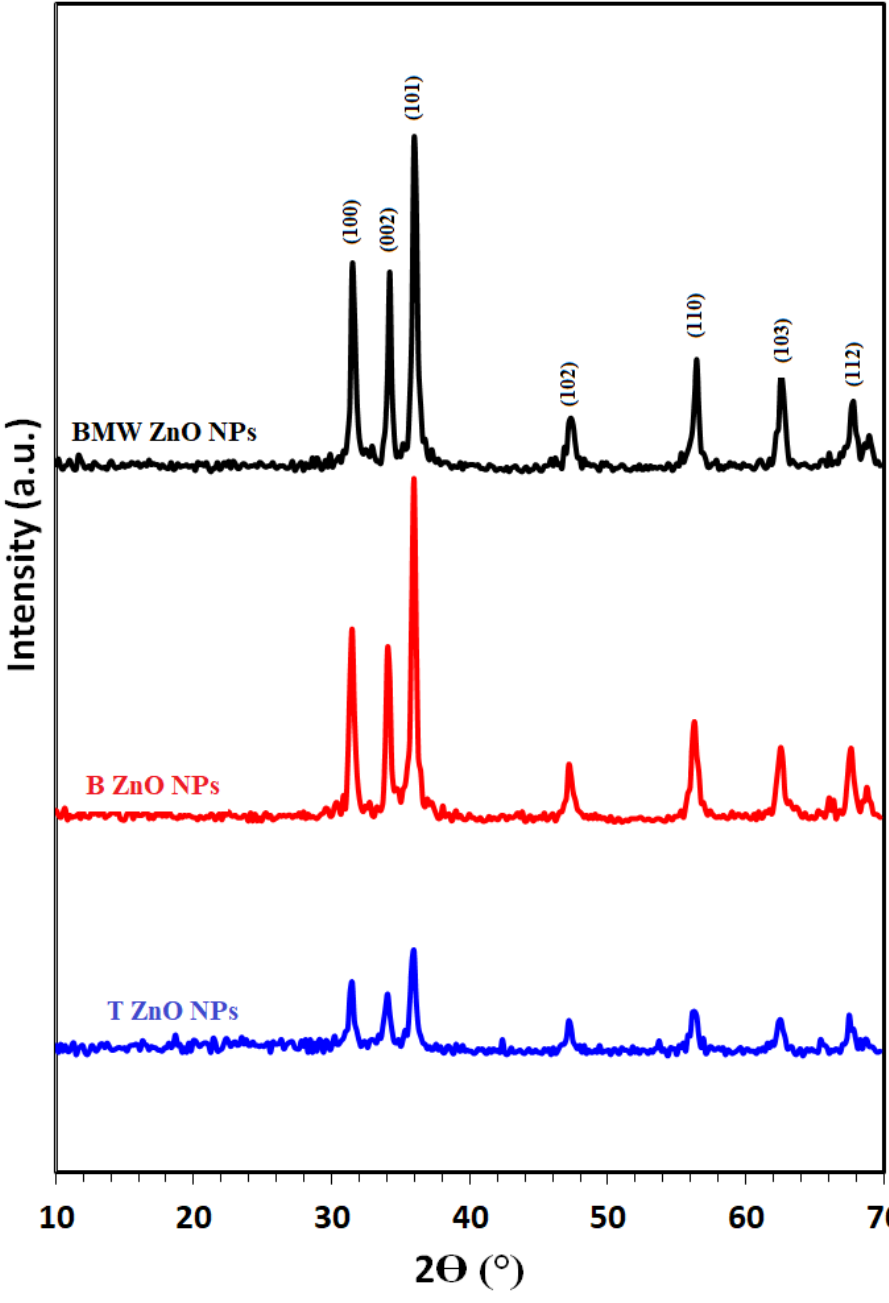
Figure 2. XRD patterns of different ZnO NPs.